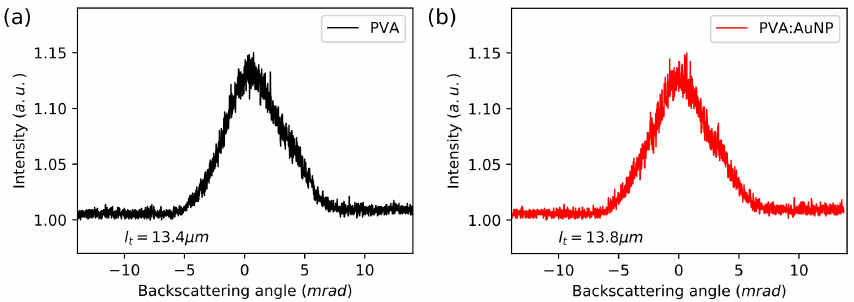
Figure 5. Backscattering cones for PVA doped Rh6G with calculated light transport mean-free path for layer ( a ) without AuNPs and ( b ) with